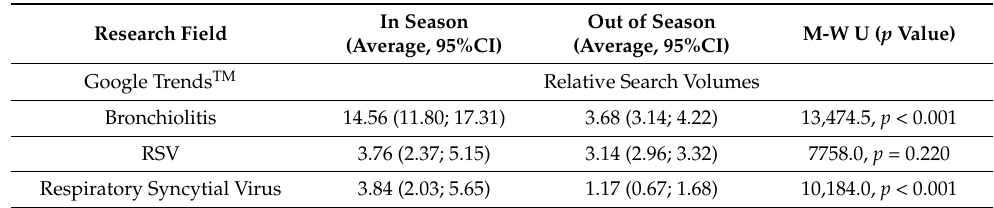
Table 6. Comparisons of the average relative search volumes for Google Trends TM keywords and daily visualizations from Italian Wikipedia for the reporting season (i.e., October–April; “in season”) vs. non reporting season (i.e., May to September; “out of season”). Data were reported with their correspondent 95% confidence intervals (95%CI). Analyses were performed by means of the Mann- Whitney test